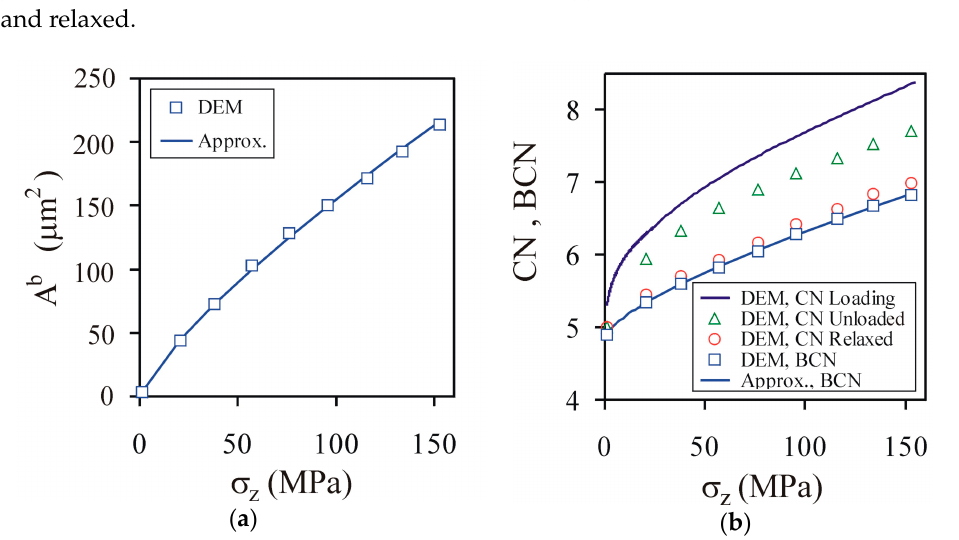
( b ) Figure 13. Experimental and DEM-simulated relationships: ( a ) tension stress σ 1 vs. deformation Δ L / D ; ( b ) tensile strength σ f vs. compaction pressure. The bars indicate the standard deviation. Taking into account the range of the variability of the parameter-fitting characteristics of individual tablets (Figure 9a) for σ z = 153 MPa ( E b ∈ 200–300 MPa, σ c ∈ 10–12 MPa), resulting from the variability of their mechanical characteristics, the applied model provided a decent approximation. To analyse the nonlinear dependence of the tensile strength of the agglomerates on